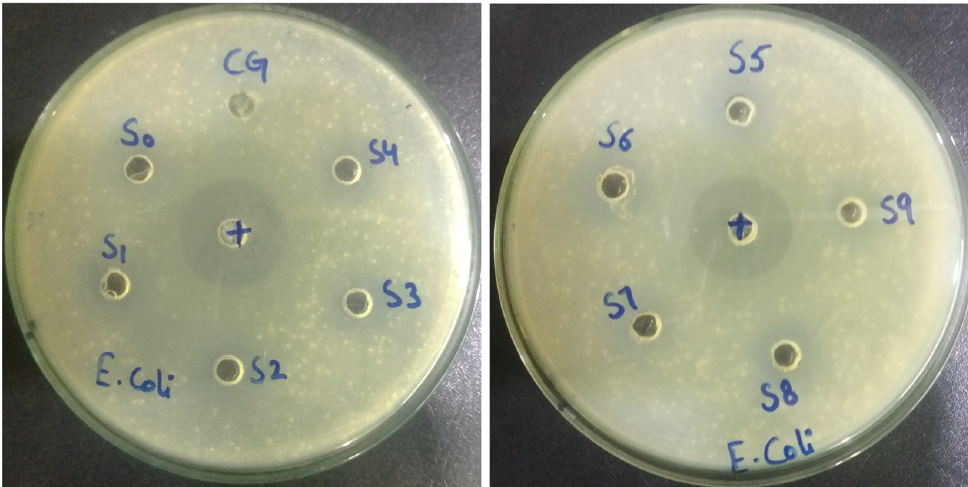
Figure 8. Nutrient agar plates showing zones of inhibition of all formulations along with commercial gel (CG), blank sample (S0), and control antibacterial Ciprofloxacin (+) against Gram-negative bacteria ( Escherichia coli ) after an incubation period of 24 h at 37 °C. Table 1. Inhibition zone measurement for antibacterial activity.